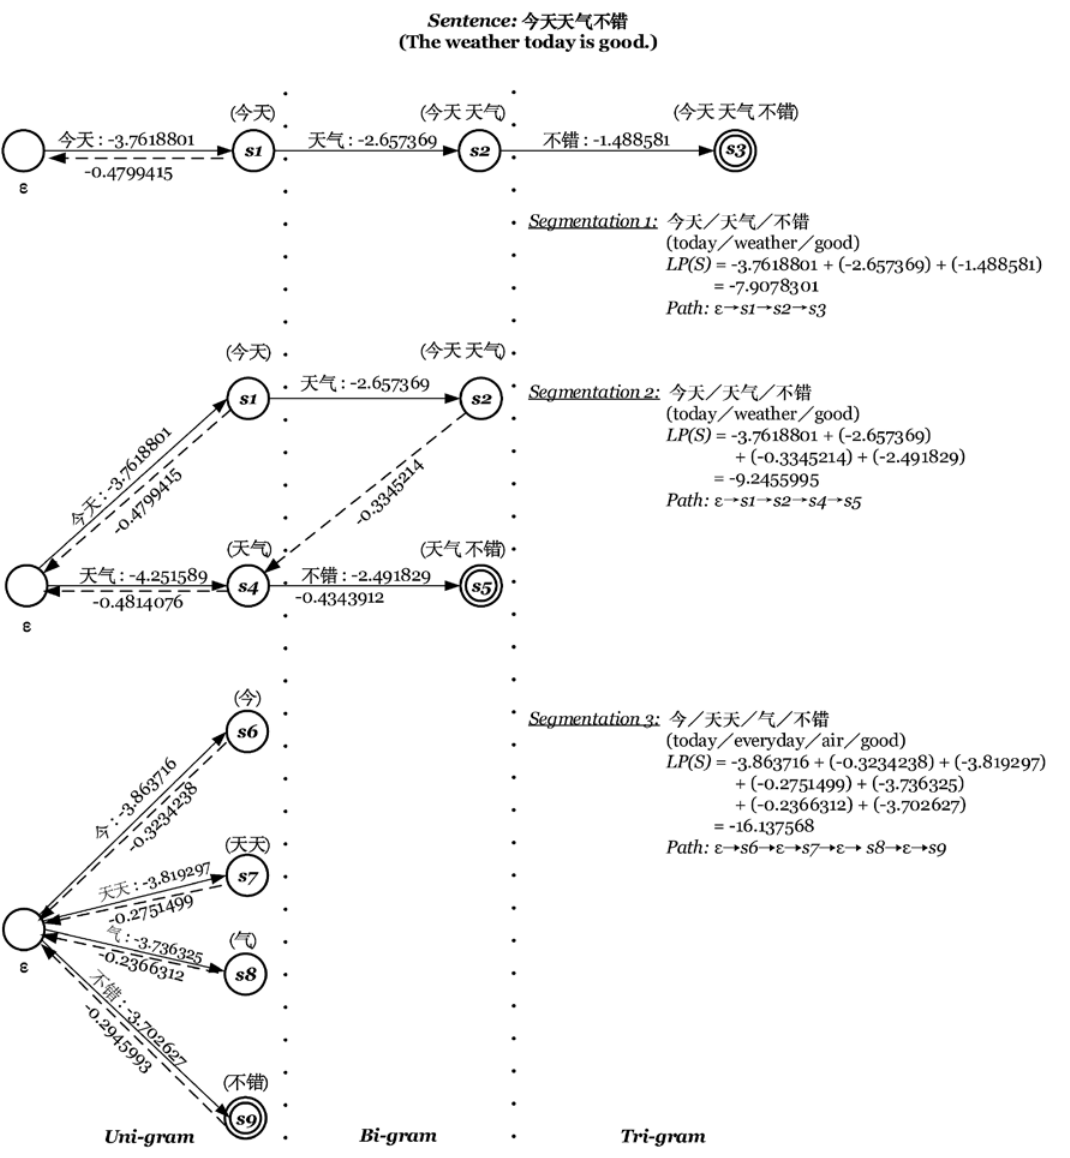
Figure 6: An Example Showing How to Recognize a Word List in a Sentence Using WFST. For clarity, we separate the WFST into three parts, though actually they are in the same